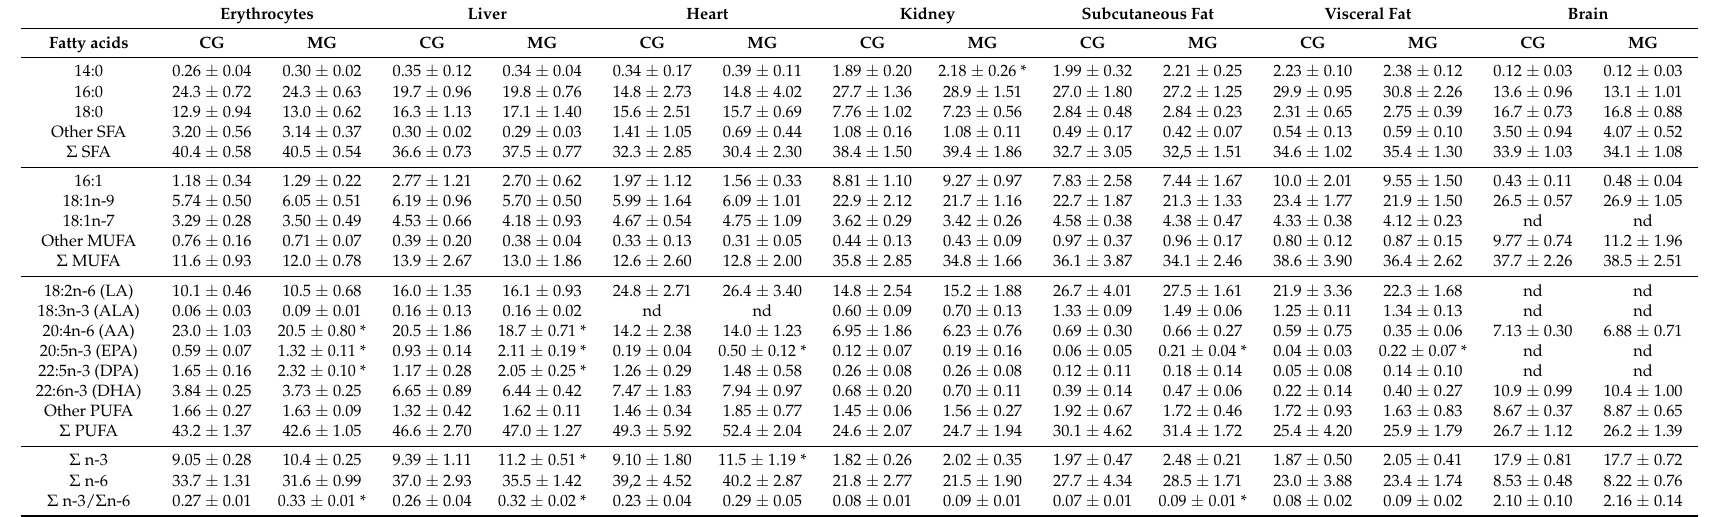
Erythrocytes Liver Heart Kidney Subcutaneous Fat Visceral Fat